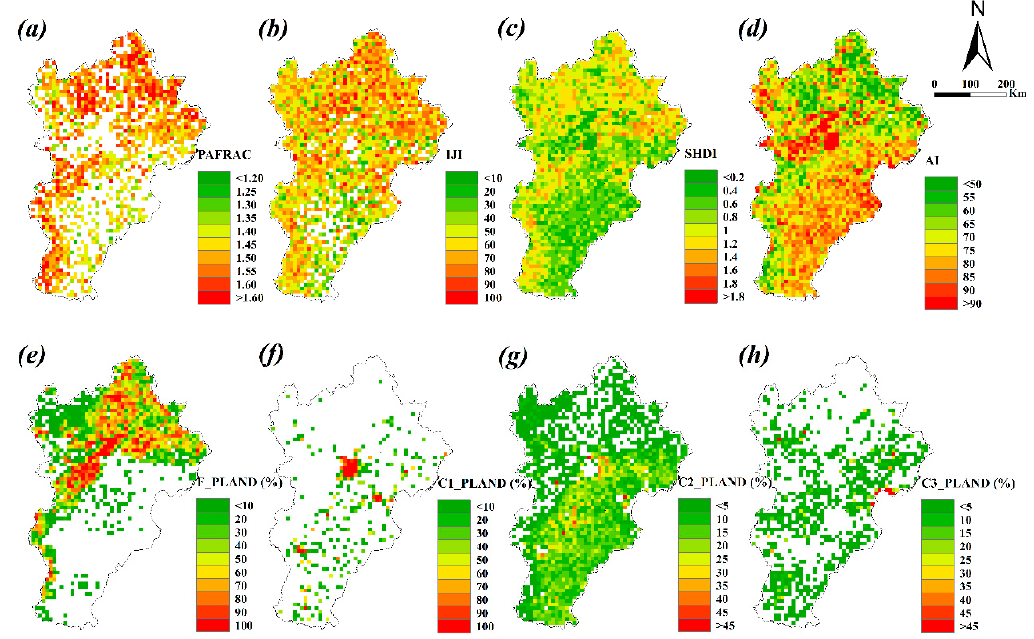
Figure 3. Landscape patterns of ( a ) PAFRAC, ( b ) IJI; ( c ) SHDI; ( d ) AI; ( e ) F_PLAND; ( f ) C1_PLAND; ( g ) C2_PLAND; and ( h ) C3_PLAND in the Jing-Jin-Ji region.